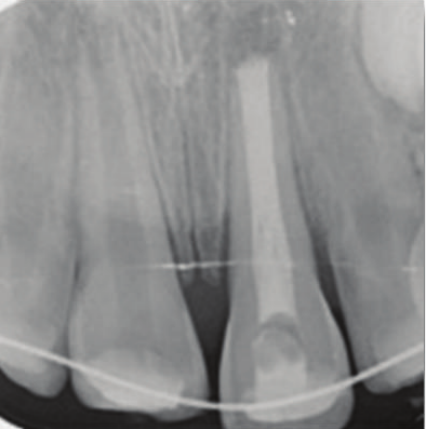
Figure 3: Periapical radiograph after immediate replantation of avulsed tooth.